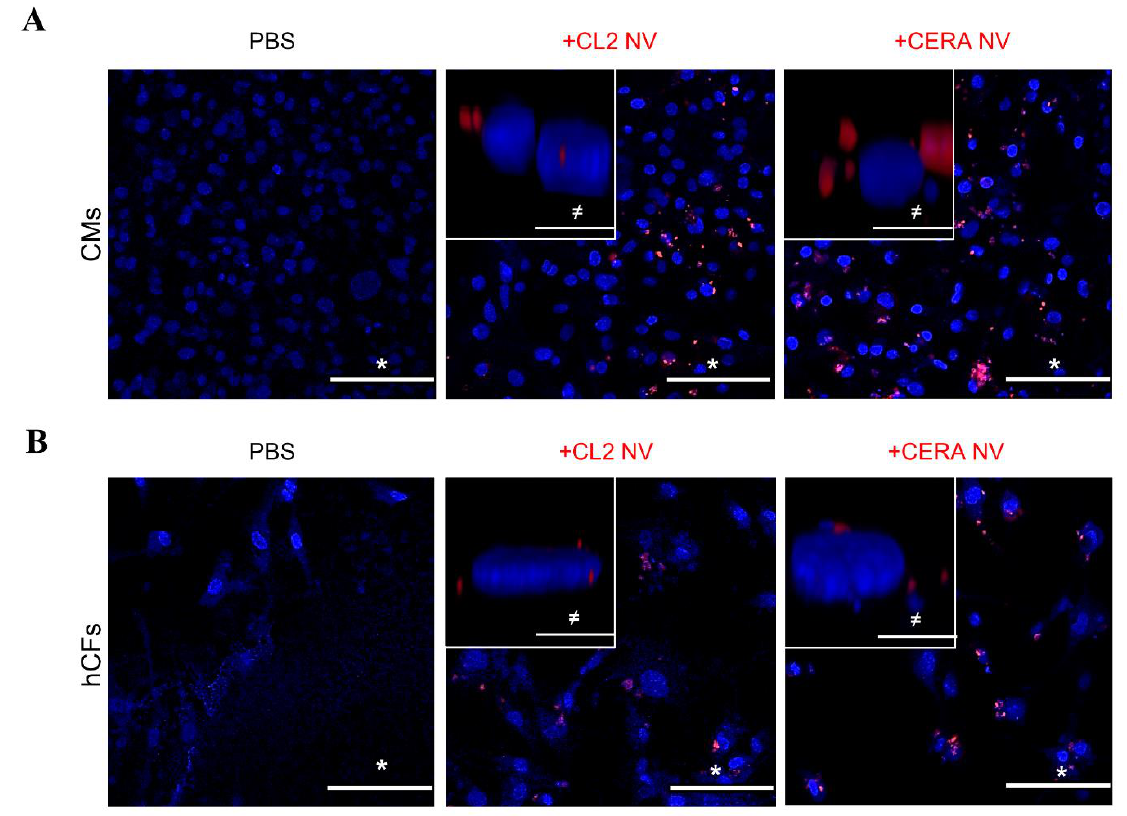
Figure 3. Internalisation of NVs by cardiac fibroblasts and cardiomyocytes. Uptake of iPSC-derived NVs by ( A ) human cardiomyocytes (CMs) and ( B ) human primary cardiac fibroblasts (hCFs). Fluo- rescence microscopy analysis of cells incubated with NVs labelled with lipophilic dye (DiI) for 2 h. DiI vehicle (PBS) control. Nuclei (blue) were stained with Hoechst. Scale bar, * 100 μm, ≠ 10 μm.